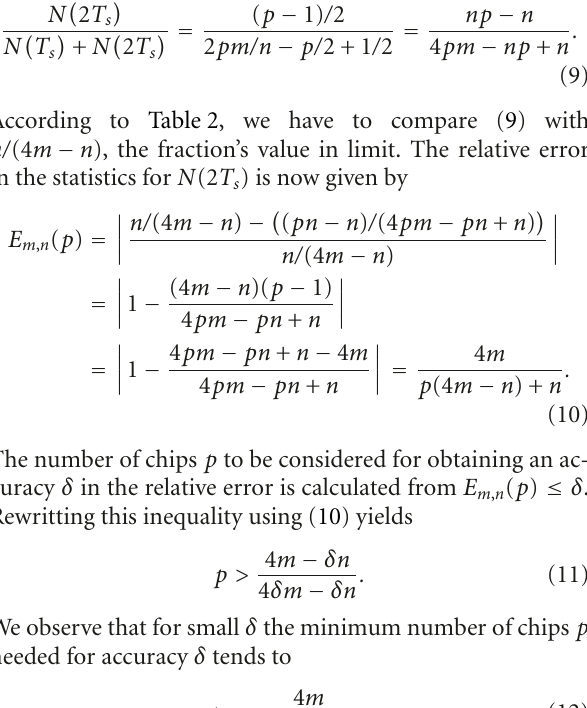
Figure 5: Number of chips p needed to reach accuracy δ for di ff er- ent BOC